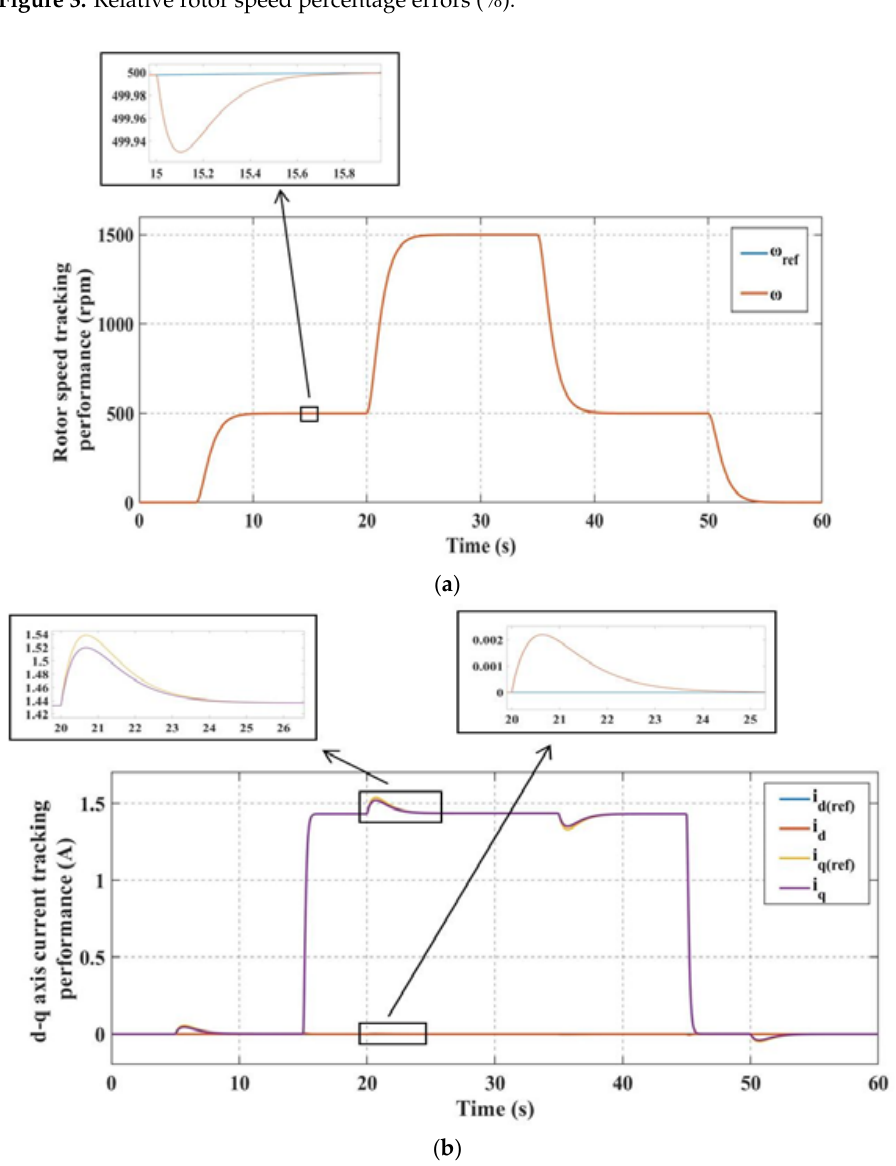
Figure 4. Motor M 8 tracking performance. ( a ) Speed; ( b ) d ‐ q axis currents.